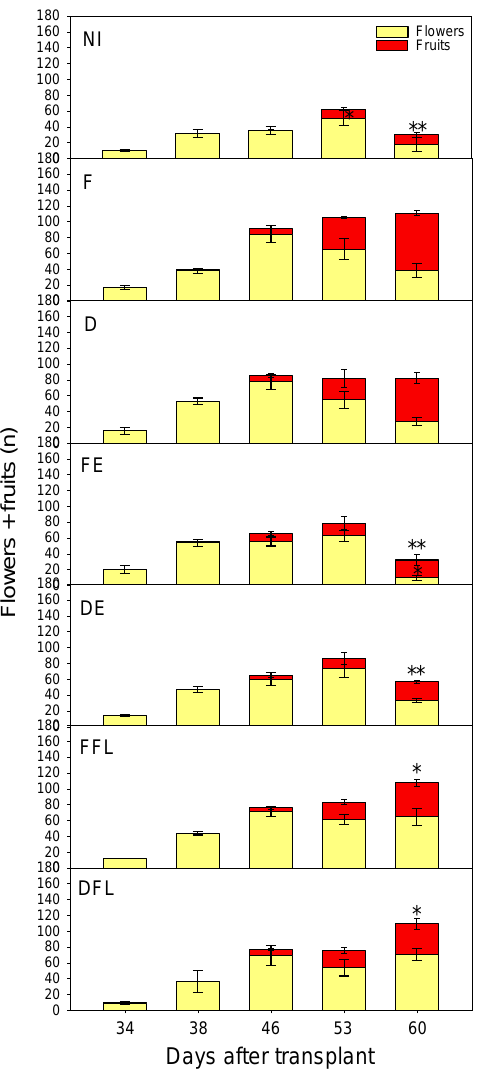
Figure 7. Course of the number of flowers and fruits per plant during the growth period in processing tomatoes cv. Hypeel F1 under different irrigation treatments. Black vertical bars represent the standard error. Asterisks, when present, indicate significance at p ≤ 0.05 (*) and p ≤ 0.01 (**) respective to the corresponding F treatment within each measurement date.